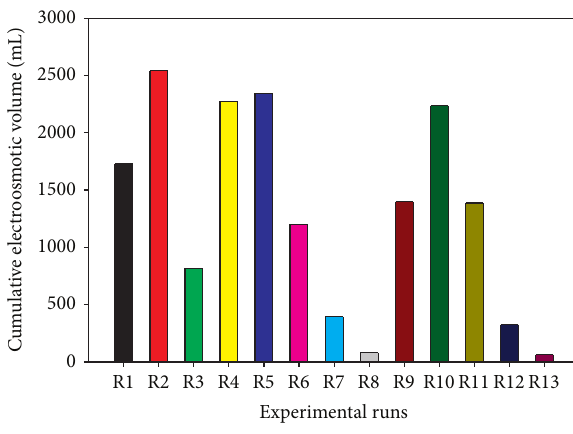
Figure 5: Cumulative electroosmotic volume for each